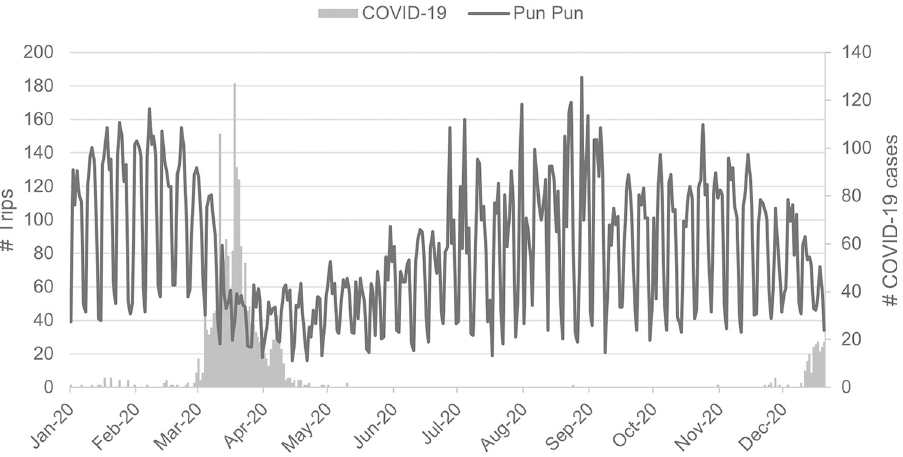
Fig 4. Bicycle-sharing trips and COVID-19 cases. Daily bicycle-sharing trips and COVID-19 cases in